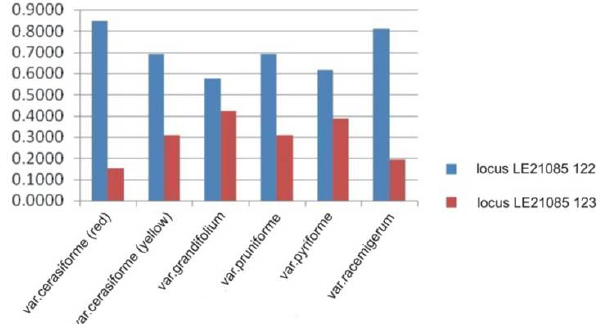
Fig. 3. The allelic variances and their frequencies for